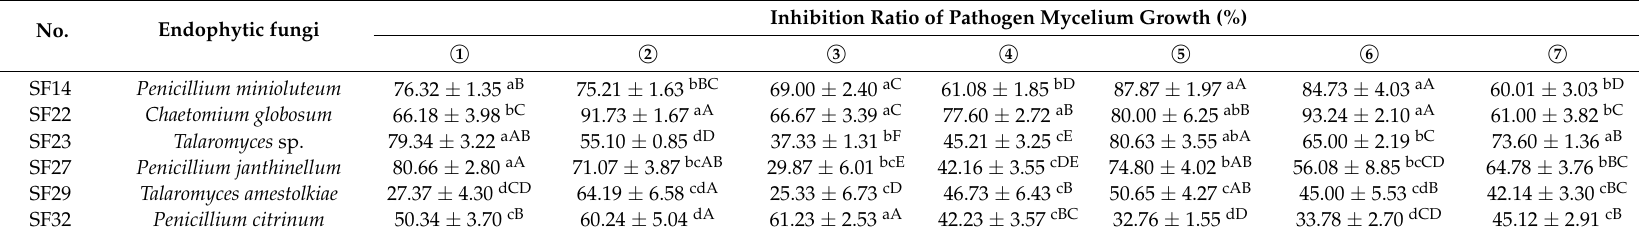
Table 4. Antimicrobial activity of the metabolites of endophytic fungi from Litsea cubeba (Lour.)